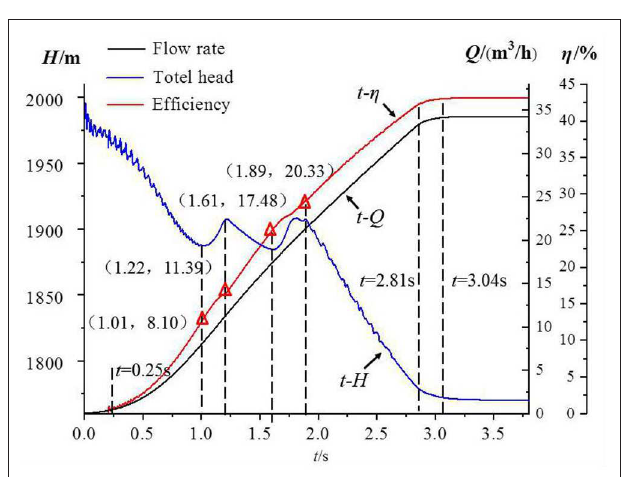
FIGURE 13 | Pump characteristic change of start-up transient state in open-valve stage.